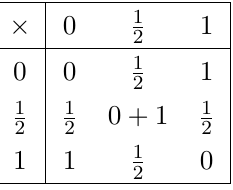
Table 1 . Fusion rules at level k = 2